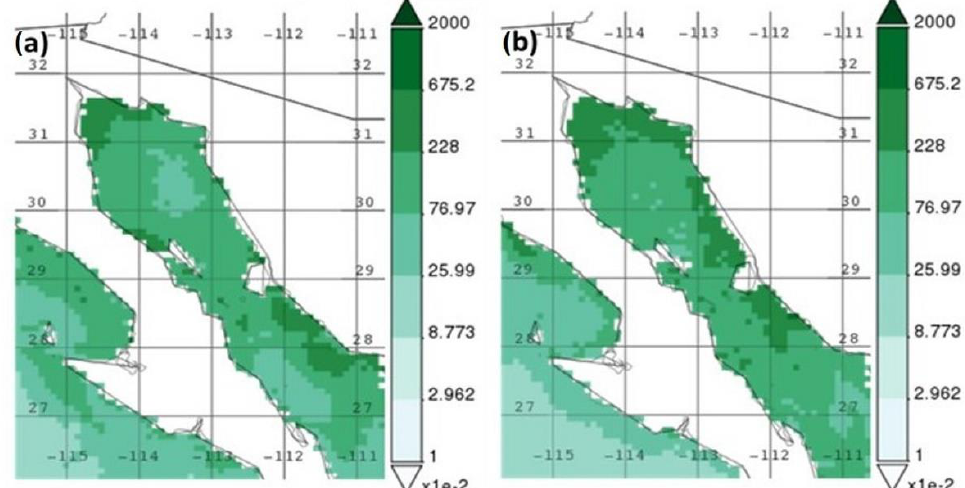
Figure 14. Chlorophyll-a concentration in logarithm scale ( mg / m 3 ) from SeaWiFS ( a ) October 15 and ( b ) October 23. Images produced with the Giovanni online data system, developed and maintained by the NASA GES DISC featuring SeaWiFS project data.